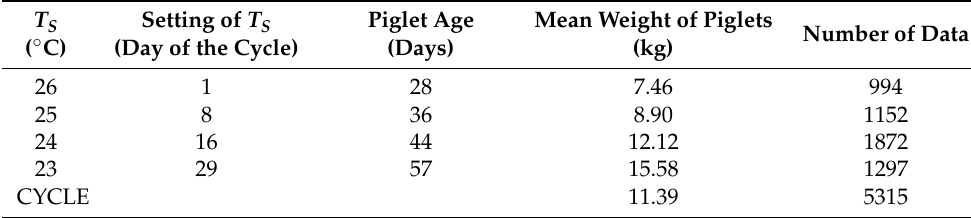
Table 1. Setpoint temperature ( T S ), day of the cycle on which T S was set, piglet age, mean weight of piglets, and number of data.